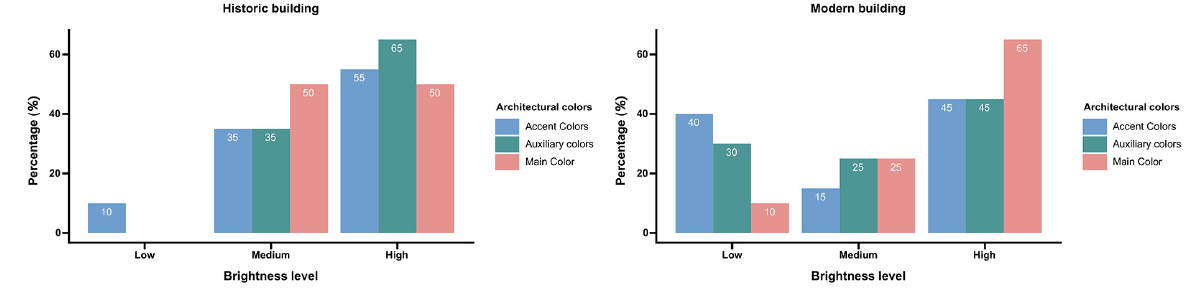
a tendency to use medium and high brightness colors (Figure 11).